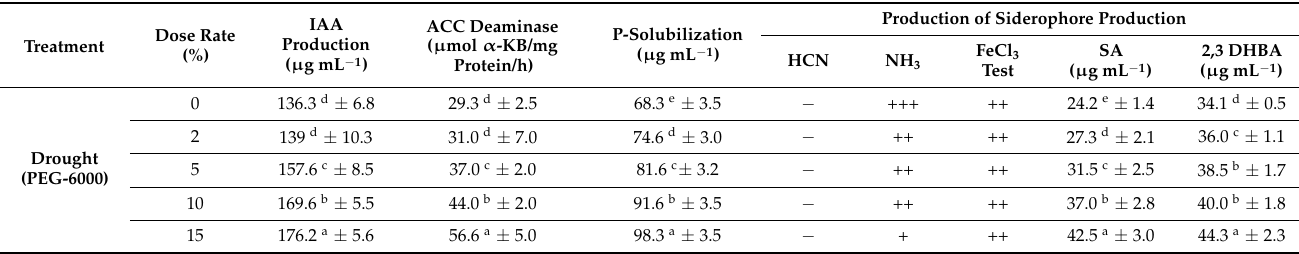
Table 2. Quantification of PGP substances or activity of Enterobacter sp./ L. adecarboxylata PAB19 grown with 2–15% PEG-6000